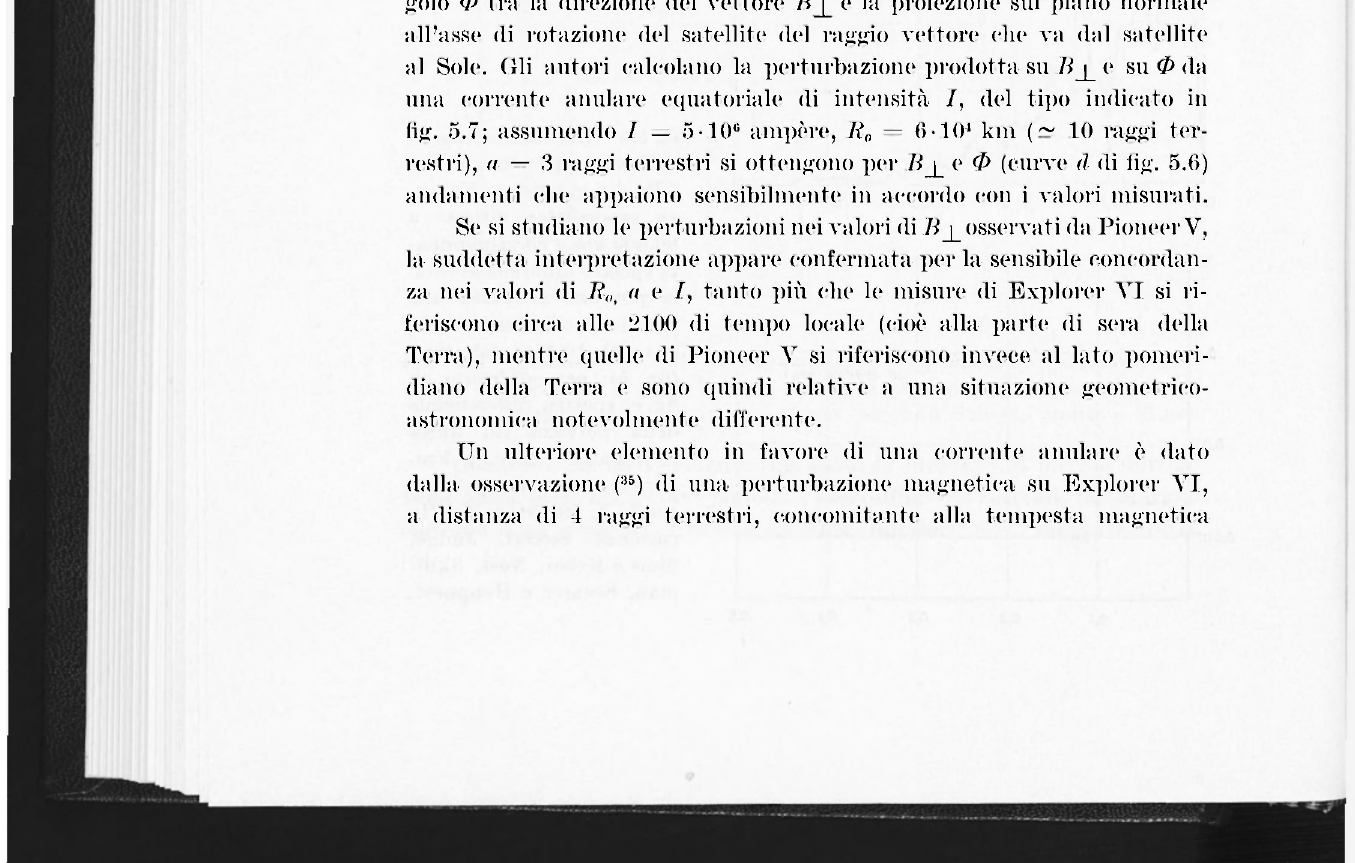
fig. 5.7; assumendo I — 5-IO 6 ampère, R„ — 6-IO 4 km (~ 10 raggi